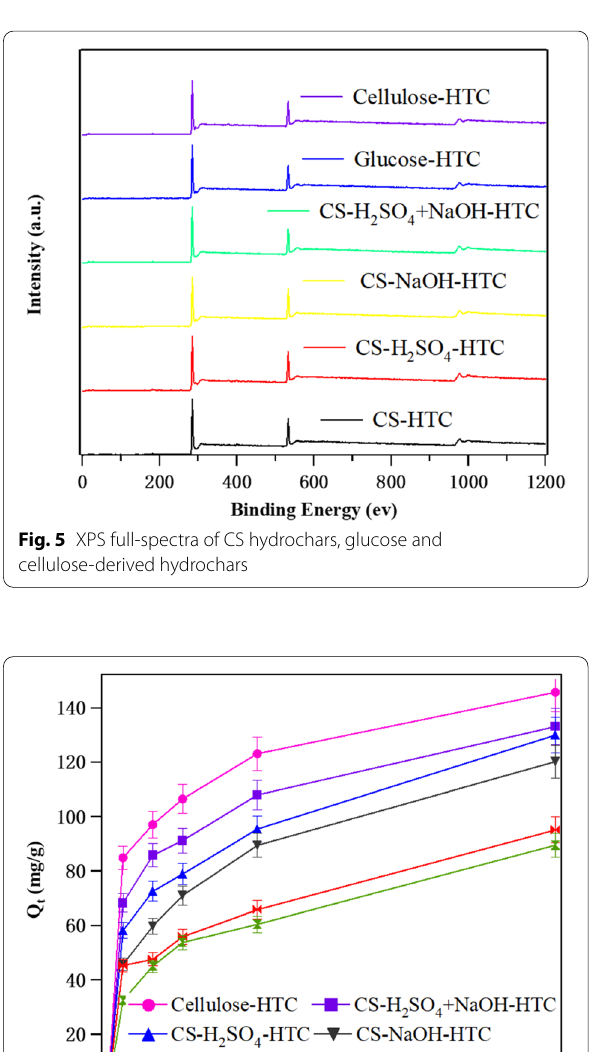
Comparison of different hydrochar samples